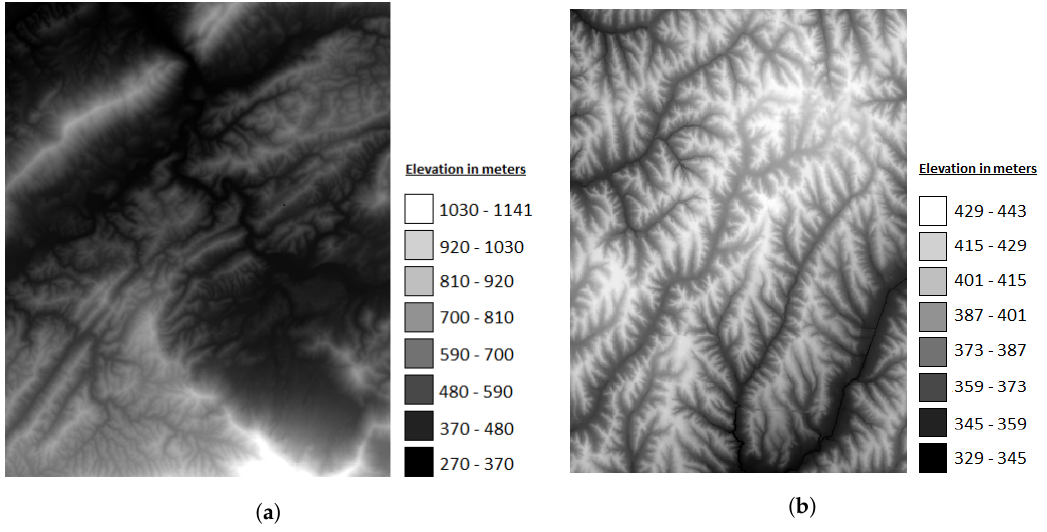
Figure 3. Terrains used in the experiments. ( a ) Kinzel Springs , Tennessee : 35.75 N, 35.625 S, − 83.875 W, − 83.75 E; ( b ) Moorehead SE , Iowa : 41.875 N, 41.75 S, − 95.875 W, − 95.75